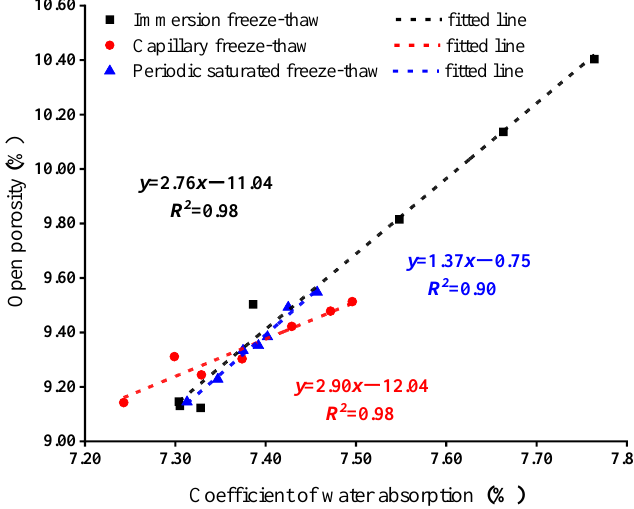
Figure 11. Relationship between rock water absorption and open porosity.